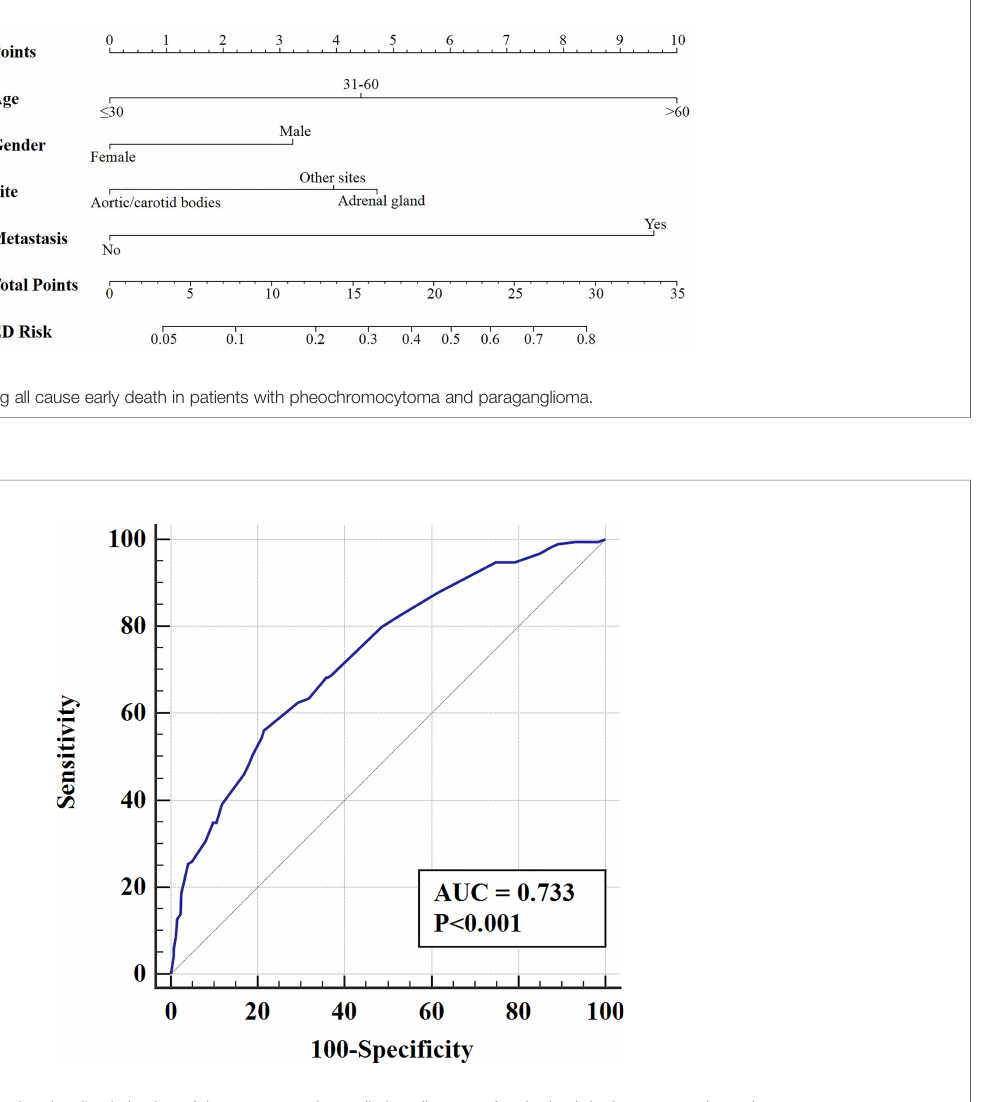
FIGURE 2 | The ROC curve for assessing the discrimination of the nomogram in predicting all cause of early death in the construction